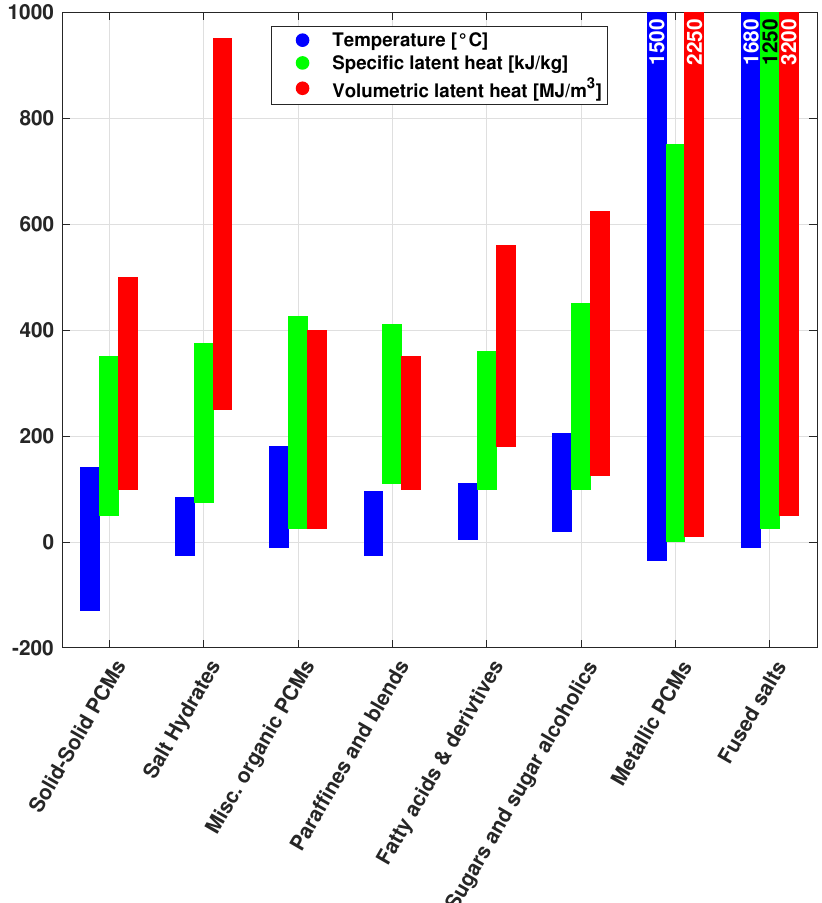
Figure 8. Transition temperature, specific latent heat and volumetric latent heat for different classes of PCM (data from